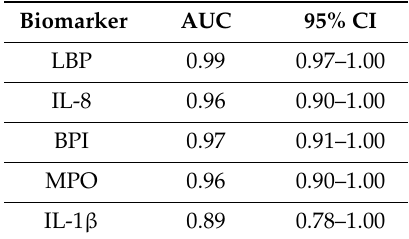
Figure 4. Discrimination between nHem, Hem and Ctrl patients when using di ff erent biomarkers. ( A – C ) Comparison of IL-8, LBP and BPI levels in the BALF of nHem ( n = 13) and Hem patients with IPA ( n = 6) as opposed to the control patients ( n = 19). Data are presented as mean ± SEM and p -values were determined by Mann-Whitney U test, non-significant (ns) results are marked. ( D ) Comparison of AUC of cytokines including IL-1 β and MPO in BALF and CRP in serum as evaluated in ROC curve analysis for all IPA patients and those IPA patients with an underlying non-hematological disease including 95% CI. Table 3. ROC curve analysis for nHem IPA